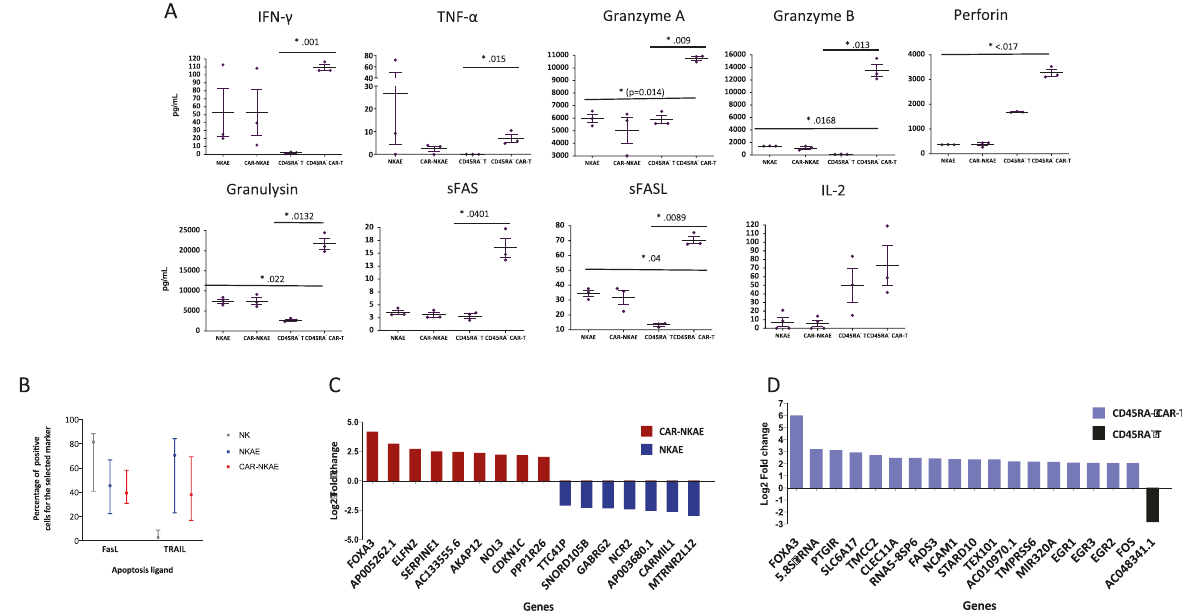
Fig. 5 Death cell mechanisms of NKAE and T-cell products. A Cytokines and cytotoxic molecules release by NKAE cells, CAR-NKAE cells, memory T cells, and memory CAR-T cells. B Expression of apoptosis ligands: FasL and TRAIL, and CD16 (antibody-dependent cell-mediated cytotoxicity) and representative fl ow cytometry density plots. RNA-seq and differential gene expression analysis were performed in C NKAE/ CAR-NKAE cells and D T /CAR-T cells. mice receiving CAR-NKAE cells survived until the end of the tumor burden 60 days after MM cell injection, showing MM clinical experiment (127 days after treatment, 129 after MM cells infusion), signs and high bioluminescent signal (Fig. 7B). Mice receiving and 25% (2/8) of them remained disease free with no NKAE cells (NKAE group) showed extended survival, with half of bioluminescence signal (Fig. 7A and B) Flow cytometry for GFP- mice dying 100 days after treatment administration. Only those